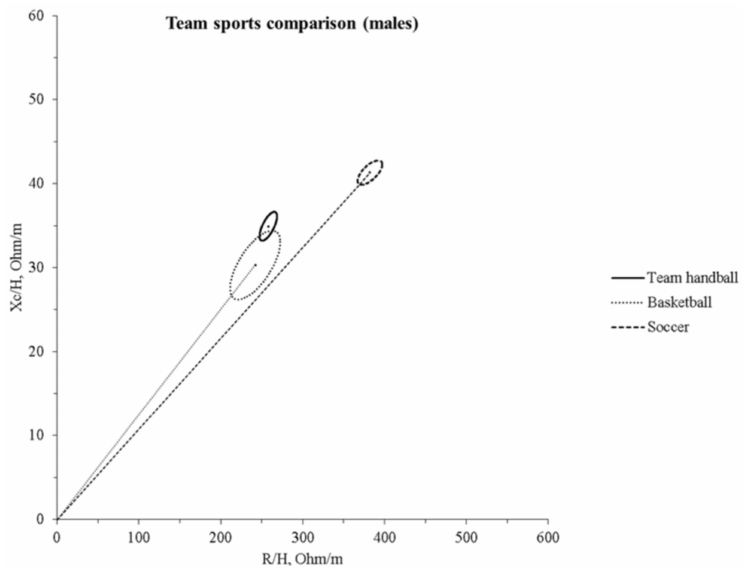
Figure 4. The 95% confidence ellipses for the mean impedance vectors of the male Italian youth team handball selections and the basketball [28] and soccer [31] reference populations are shown. R/H, height-adjusted resistance; Xc/H, height-adjusted